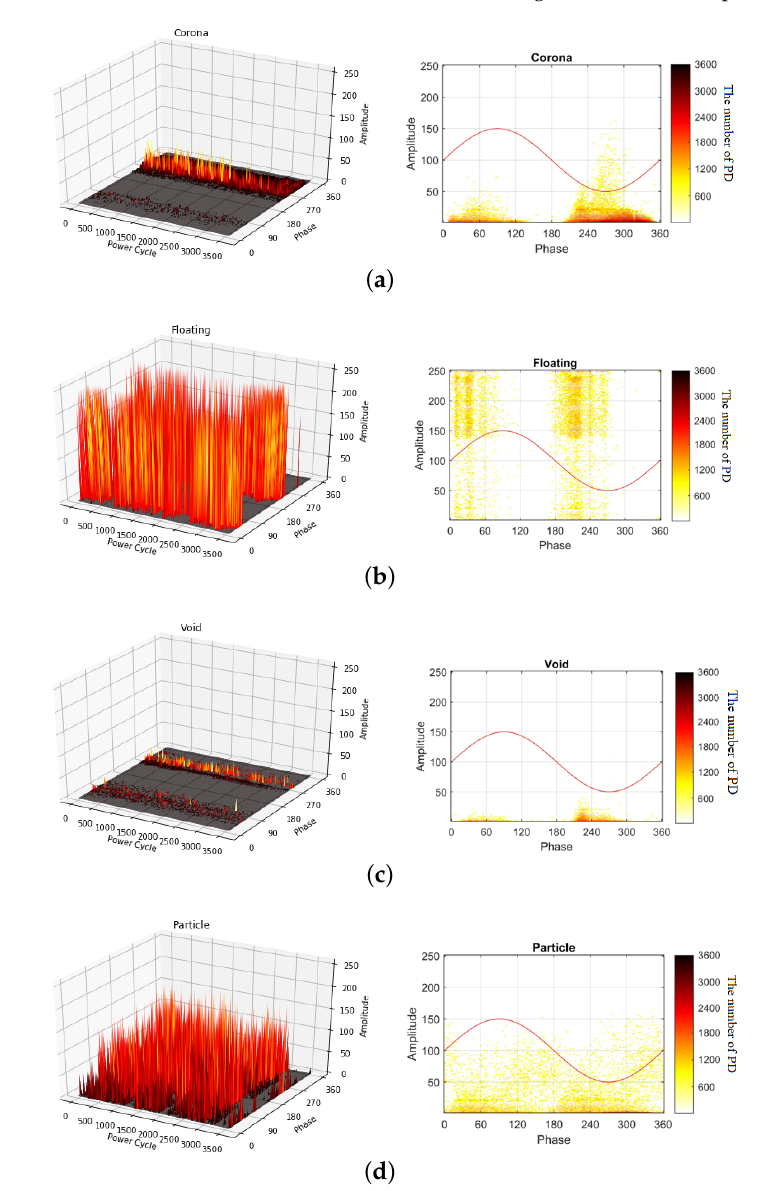
Figure 3. Examples of PRPDs in 3D and 2D representations: ( a ) corona, ( b ) floating, ( c ) void, and ( d ) particle